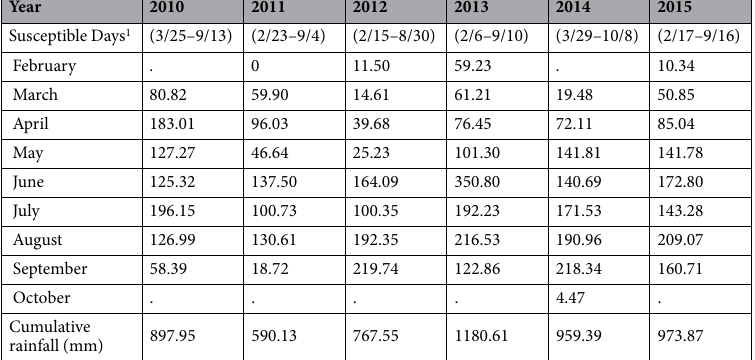
Table 2. Cumulative Rainfall in mm for Susceptible Days 1 from 2010 to 2015 measured at the FAWN, southwest Florida Immokalee weather station. 1 Susceptible Days are the number of days when fruit are on the tree and are considered susceptible to infection by Phyllosticta citricarpa (between fruit set and 5 month post fruit set (mpfs)). Dates in brackets represent the estimated date of earliest fruit set and latest date of susceptibility at 5 mpfs. A period (.) indicates that there was no days in the respective month where there were fruit on the tree, therefore no rainfall data is reported for that